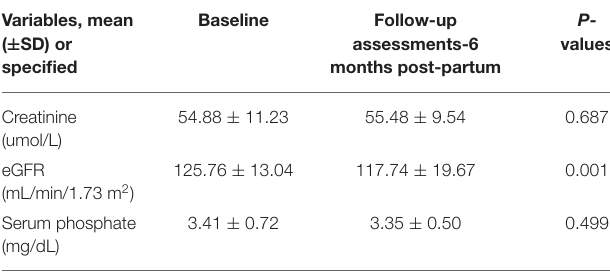
TABLE 4 | Maternal renal function and serum phosphate changes in the study.